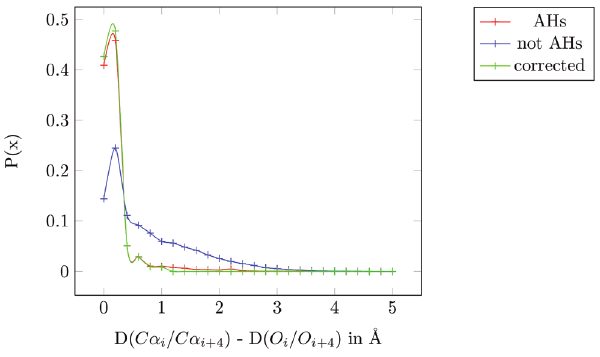
Figure 1. Plot of the difference between D( C α O ). All 775 AHs specified in the PDB files from the 100 non- i +4 homologous high resolution structures taken from the PISCES database are in red (mean=0.16 Å , standard deviation (sd)=0.34 α Å ). All residues separated by four residues but not part of a helix are in blue (mean=0.71 Å, sd=0.75 Å ). All AHs specified in the PDB files after correction are in green (mean=0.095 Å and sd=0.14 Å